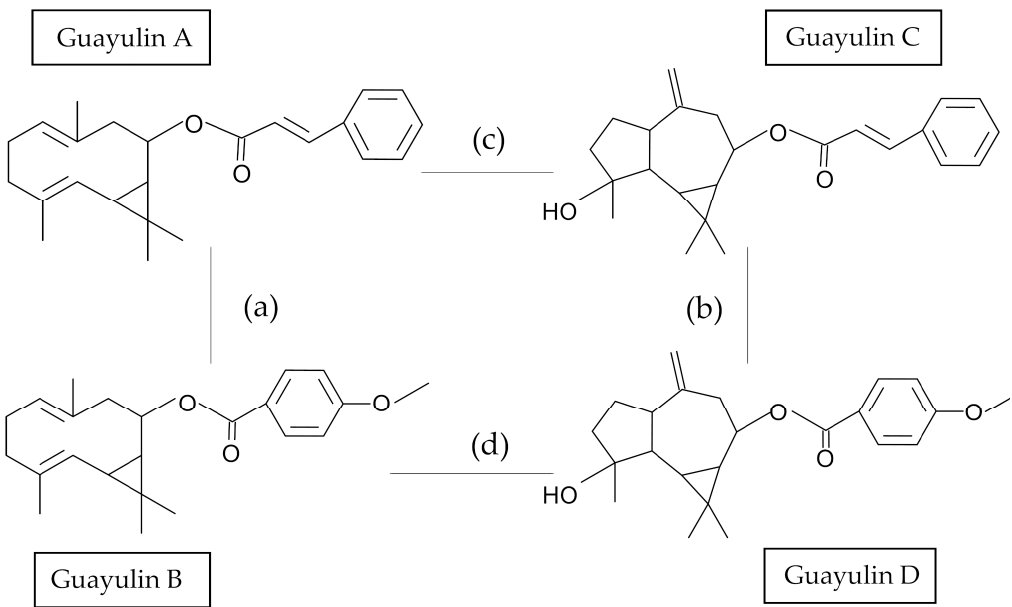
Figure 1. Structure of the four main guayulins, and the relationship between them: ( a ) guayulins related with a bicycloger- macrene structure (Guayulins A and B); ( b ) guayulins related with an aromadendrane structure (Guayulins C and D); ( c ) guayulins esterified by trans -cinnamic acid (Guayulins A and C); ( d ) guayulins esterified by p -anisic acid (Guayulins B and D).